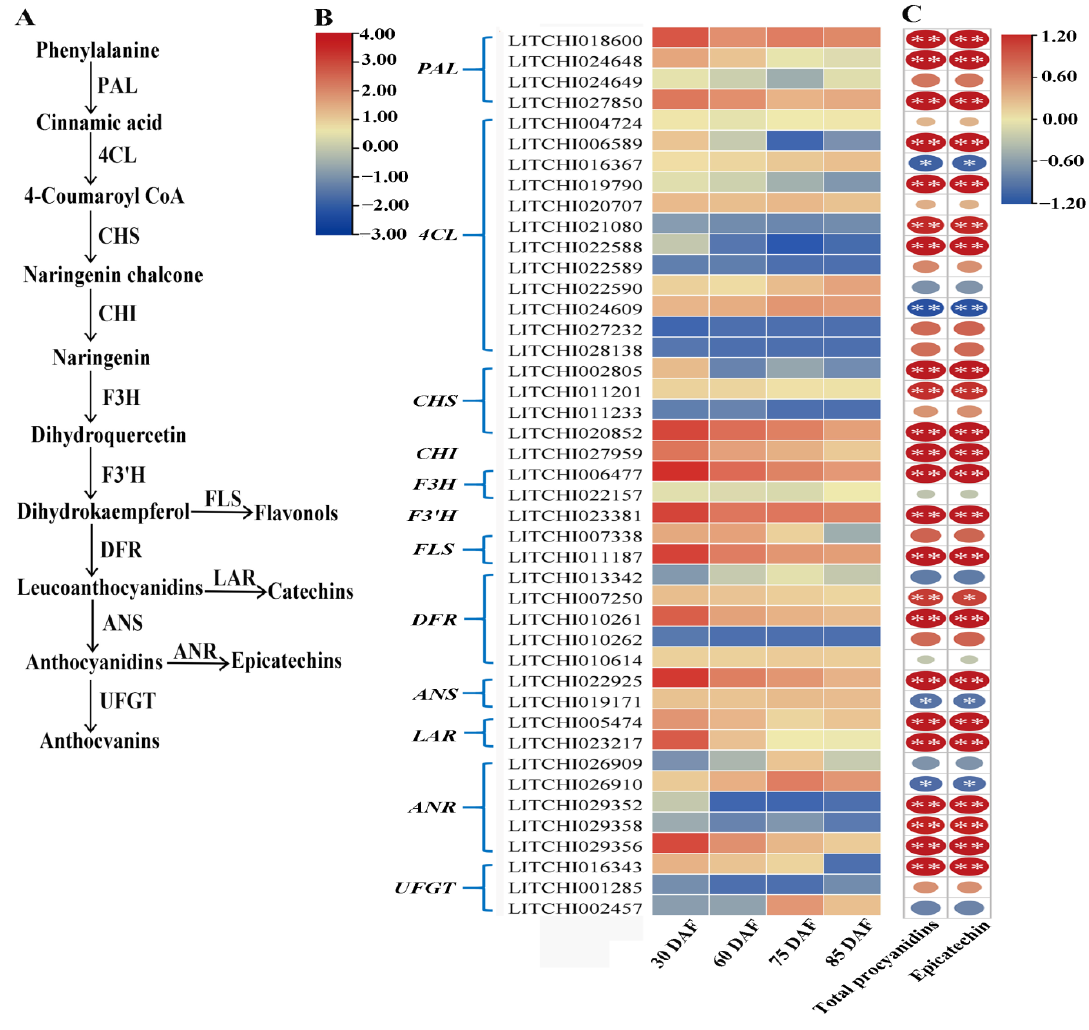
Figure 4. Scheme of the proanthocyanidin biosynthesis pathway and correlation of flavonoid/proanthocyanidin biosynthesis-related gene expression and EC/PC accumulation during litchi fruit development. ( A ) Enzyme names are abbreviated as follows; PAL, phenylalanine ammonia lyase; 4CL, 4 coumarate CoA ligase; CHS, chalcone synthase; CHI, chalcone isomerase; F3H, flavanone 3-hydroxylase; F 3′ H, flavanone 3 ′ -hydroxylase; DFR, dihydroflavonol reductase; FLS, flavonol synthase; ANS, anthocyanidin synthase; UFGT, UDP-flavonoid glucosyltransferase; ANR, anthocyanidin reductase; and LAR, leucoanthocyanidin reductase. ( B ) Heatmap of the genes involved in flavonoid/proanthocyanidin biosynthesis in the fruit development stages, as described in Figure 4A. The color from blue to red represents low to high gene expression levels, based on the RNA-seq analysis. Colors indicate relative abundance, ranging from blue (low) to red (high). ( C ) Pearson correlation of the gene expression levels in ( B ) and EC and total PC content. The size and color of the circles indicate the correlation coefficient, ranging from small (low) to large (high) and red (positive correlation) to blue (negative correlation), respectively. “*” and “**” in ellipses represent significant correlation ( p < 0.05) and extremely significant difference ( p < 0.01), respectively.